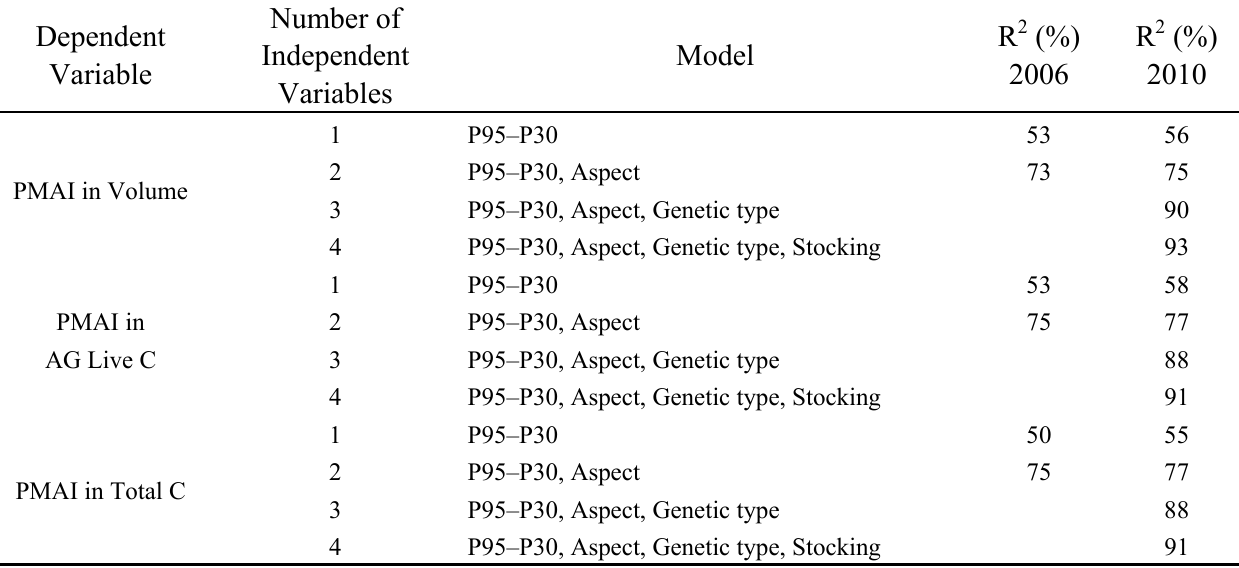
Table 8. Independent variables used to predict periodic mean annual increment (PMAI) in volume, above ground live carbon, and total carbon in 36 radiata pine plots included LiDAR (P95–P30), genetic type, aspect and stocking. Regression model R 2 values apply to 2006 or 2010 LiDAR